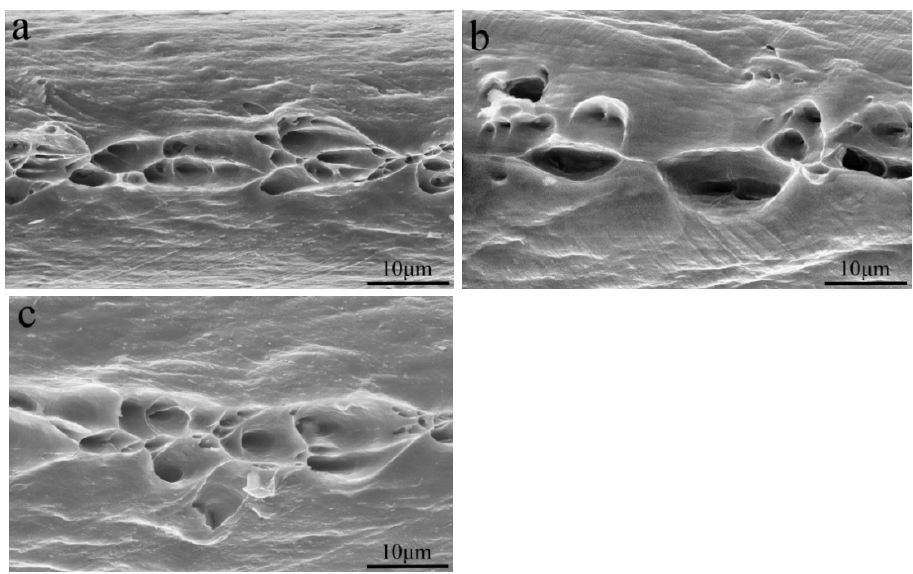
Figure 6. Tensile fracture morphology of the heat-treated foil alloys tested at 25 °C: ( a ) Al-0.2Fe- 0.06Cu; ( b ) Al-0.2Fe-0.06Cu-0.1La; ( c ) Al-0.2Fe-0.06Cu-0.15La.